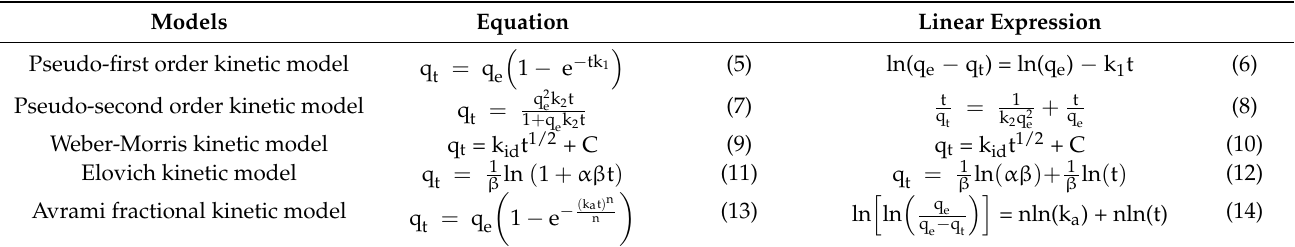
Table 4. Adsorption kinetic models in linear and non-linear